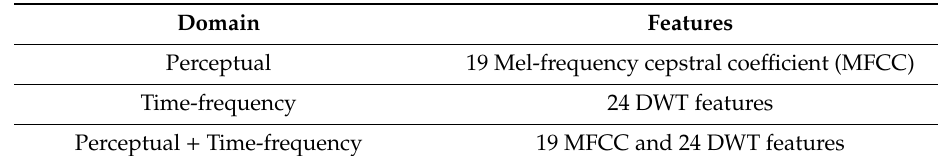
Table 7. Features used in [25].